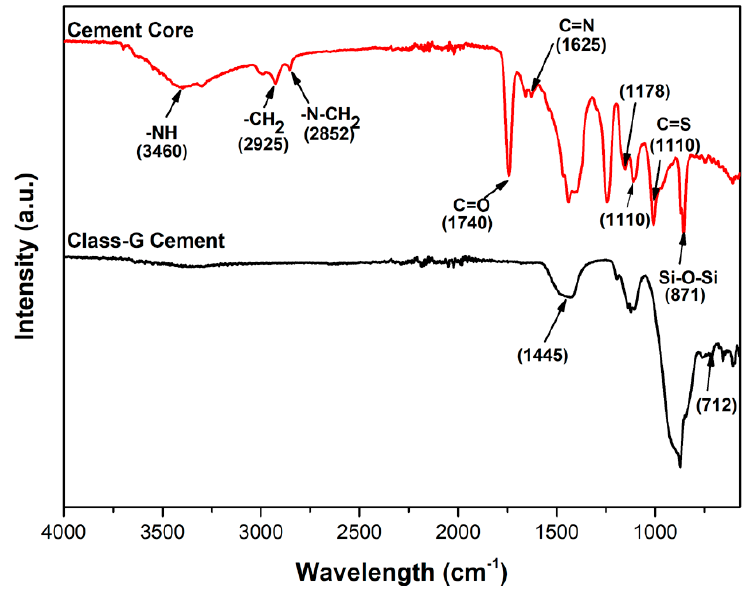
Figure 8. FTIR spectrum of cement and cement core.